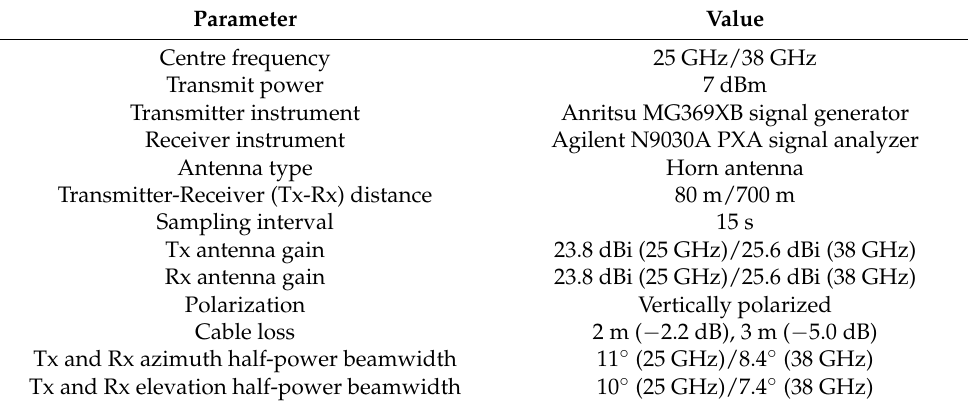
Figure 2. The transmission link and rain measurement setup. Table 1. The outdoor field millimeter-wave link measurement